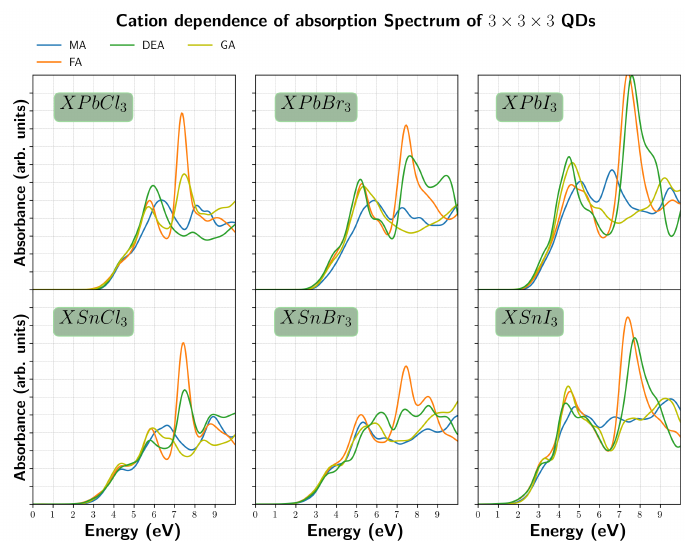
Figure 6. Dependence of the absorption spectra on the A cation type.